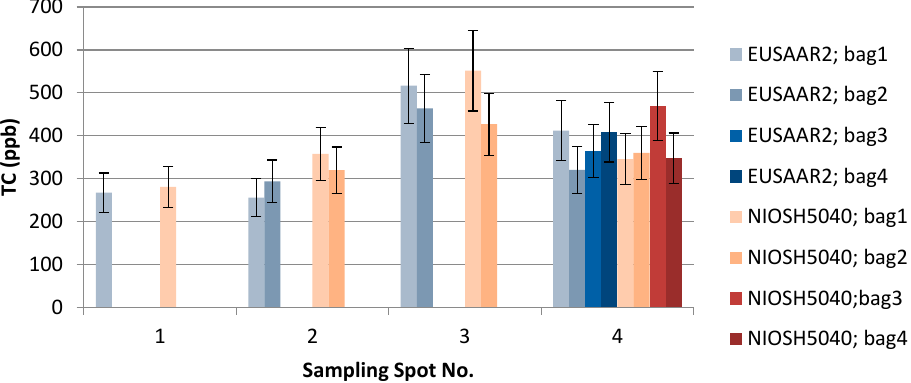
Sampling Spot No. Figure 6. The effect of EUSAAR2 and NIOSH5040 analysis protocols on the detected OC.